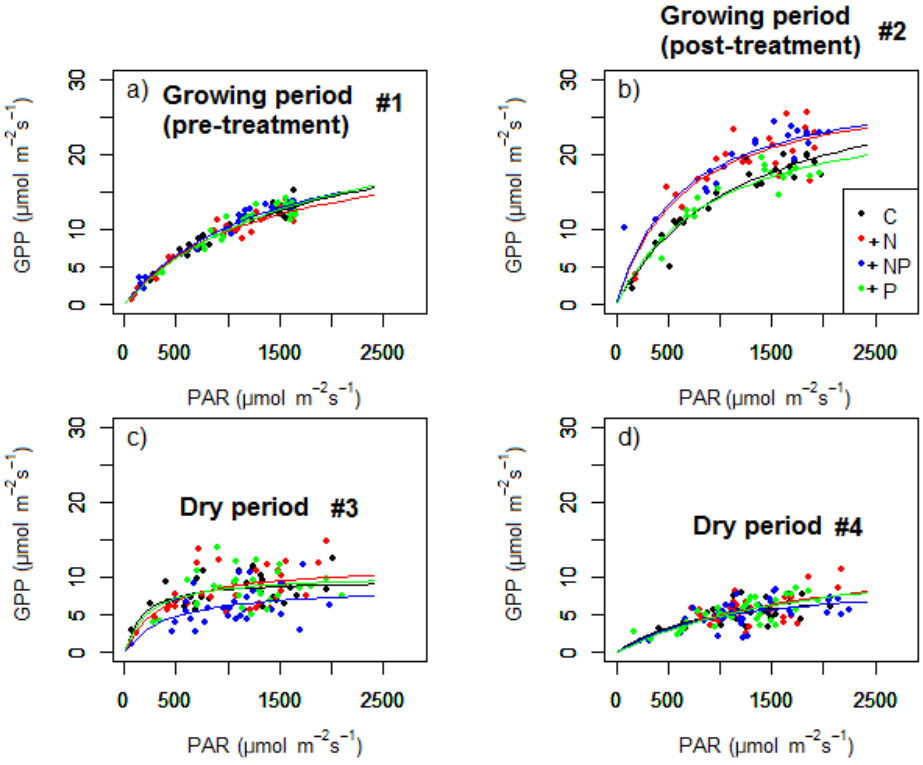
Figure 2. Photosynthetic light response curves derived for each growing period: (a) pretreatment and (b) posttreatment and drying periods ( c and d ). Treatments are presented in different colors. Lines represent the Michaelis–Menten function fitting gross photosynthesis (GPP, µmol CO 2 m − 2 s − 1 ) and photosynthetic active radiation (PAR, µmolm − 2 s − 1